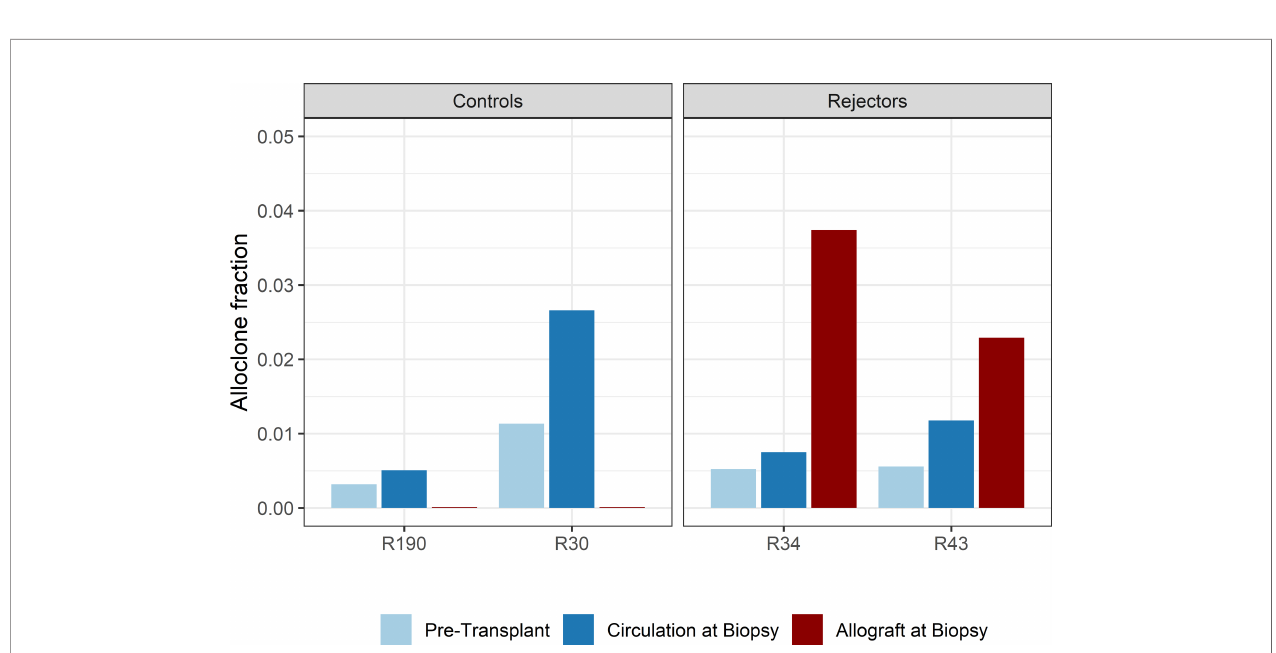
FIGURE 5 | Bar plots of the fraction of detected donor-reactive clonotypes in the renal allograft after normalization by downsampling to the smallest number of reads. An increase in donor-reactive clones in the tissue (red bar) compared to pre-transplant (light blue) and post-transplant (dark blue) in the peripheral blood